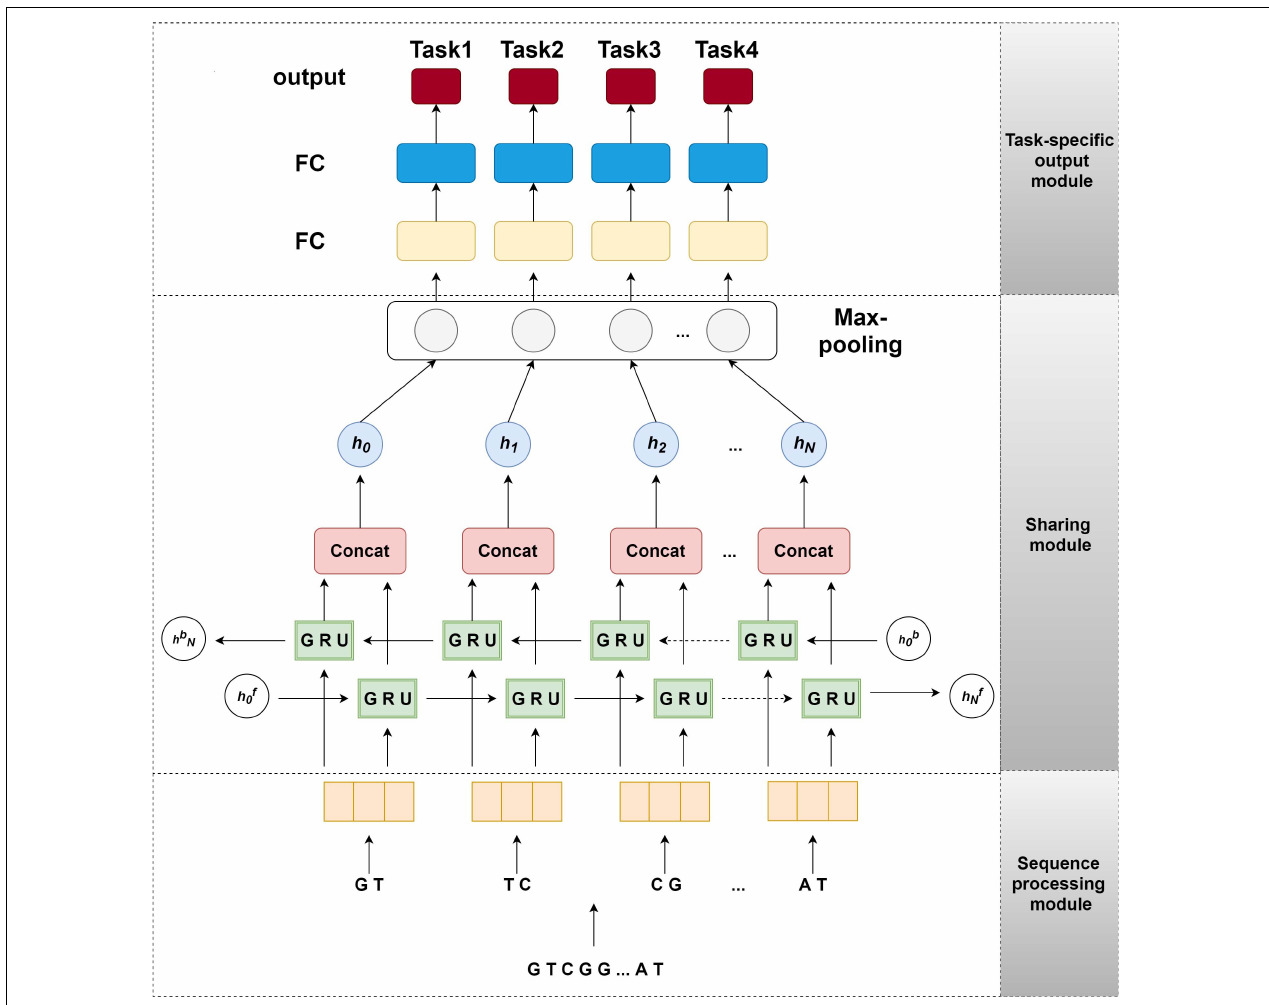
FIGURE 1 | The structure of iDNA-MT. The sequence processing module uses 2-gram to split an original DNA sequence into overlapping subsequences and converts them into feature vectors by one-hot encoding. Next, the feature vectors of subsequences are sent into sharing module, containing a BGRU and a max-pooling layer, to capture the sharing information among different species. Finally, the output of sharing module is fed into the task-specific output module to predict the modification site (i.e., 4mA or 6mC) of a certain